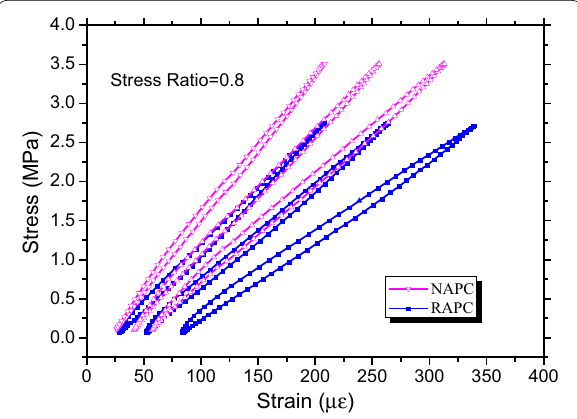
Fig. 6 Hysteresis loop under different cycle ratio at stress level of 0.8.